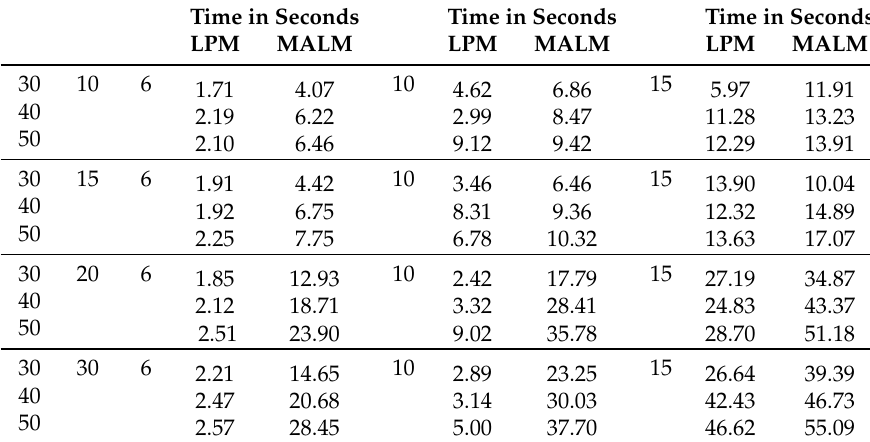
Table 2. Numerical results of Example